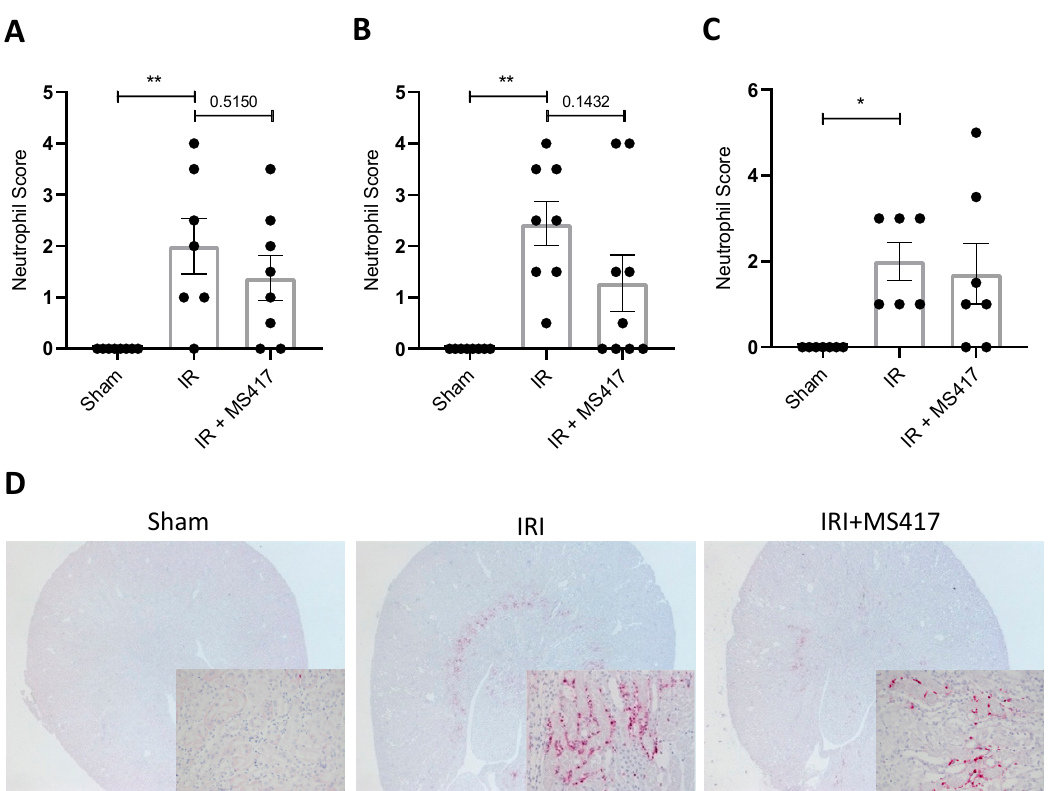
Figure 8. BRD4 inhibition attenuated neutrophil infiltration in kidney tissue following IRI ( A – C ) Semi-quantitative scoring of neutrophil infiltration on Ly6B.2 clone 7/4 stained kidney sections from 6 h ( A ), 24 h ( B ), and 48 h ( C ) performed in a blinded manner. ( D ) Representative images of neutrophil infiltration on Ly6B.2 clone 7/4 stained kidney sections performed at 24 h in Sham, IRI and IRI + MS417 mice. Images are at 1.6× magnification with high magnification inserts at 20×. n = 7–9, * p < 0.05, ** p < 0.01.